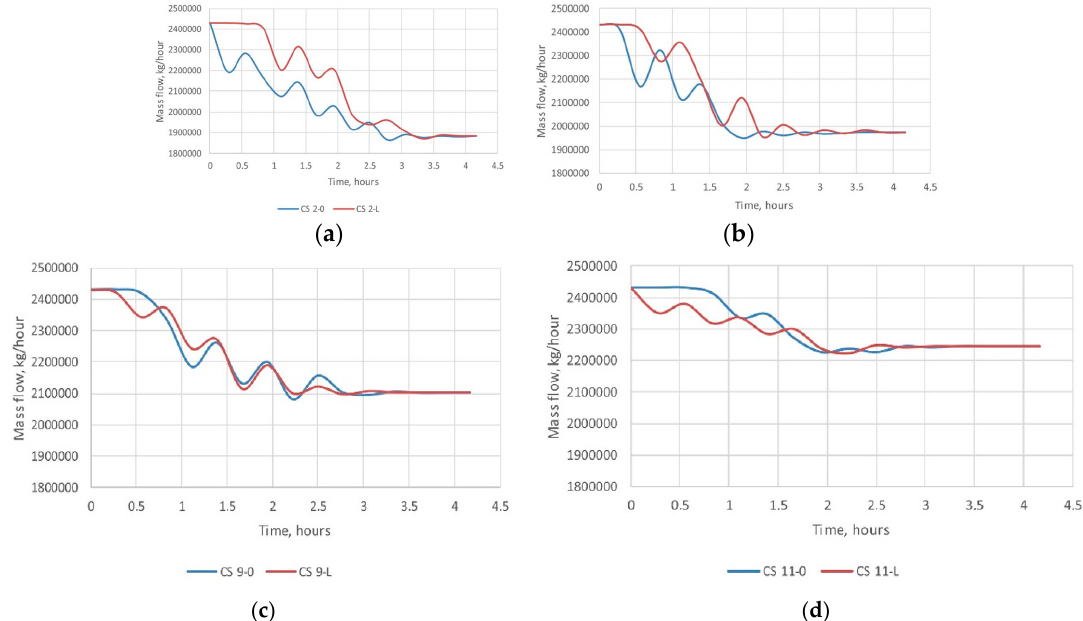
Figure 2. Regularities in the unsteady process upon shutdown of the CS (fluctuations of mass flow over time): ( a ) at the beginning of the gas pipeline; ( b , c ) at the middle of the gas pipeline; ( d ) at the end of the gas pipeline;